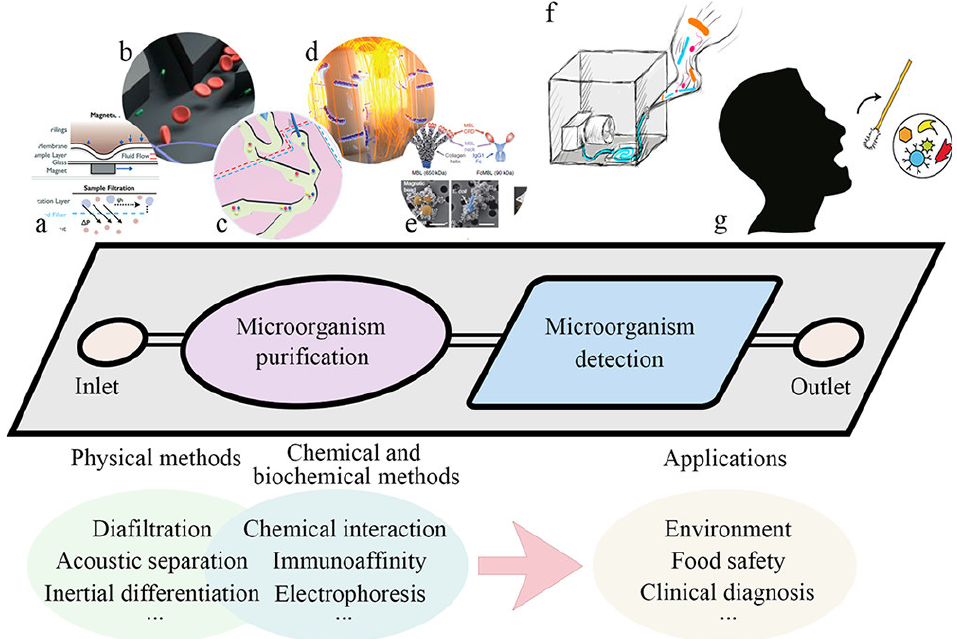
Figure 1. Schematic illustration of on-microchip microbial analysis, combining ( a – e ) on-chip purifi- cation of target microbes and detection methods for ( f , g ) applications, e.g., environmental monitoring and clinical diagnosis. Reproduced with permission from ref. [25]. Copyright 2018 American Chemical Society.